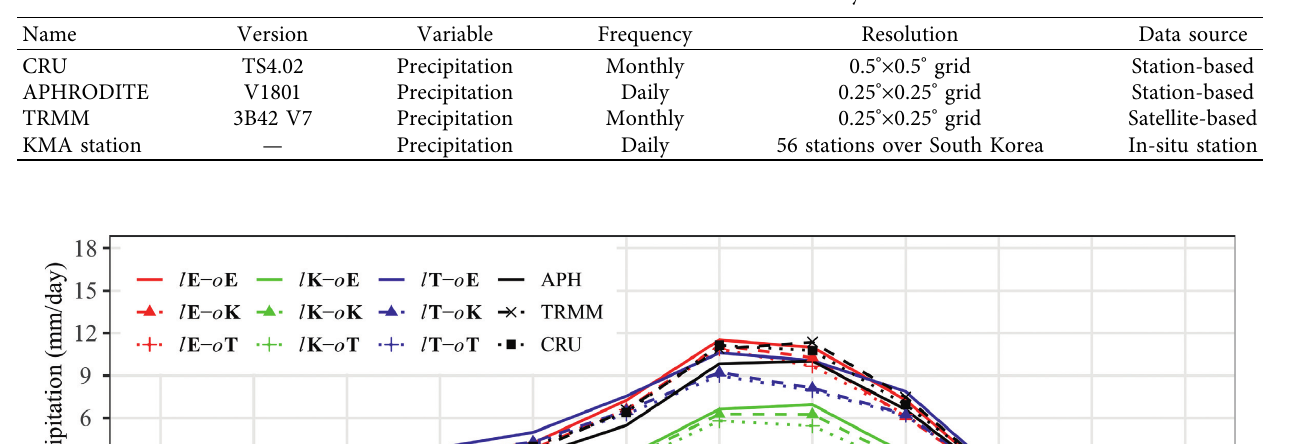
Table 2: Observation datasets used in this